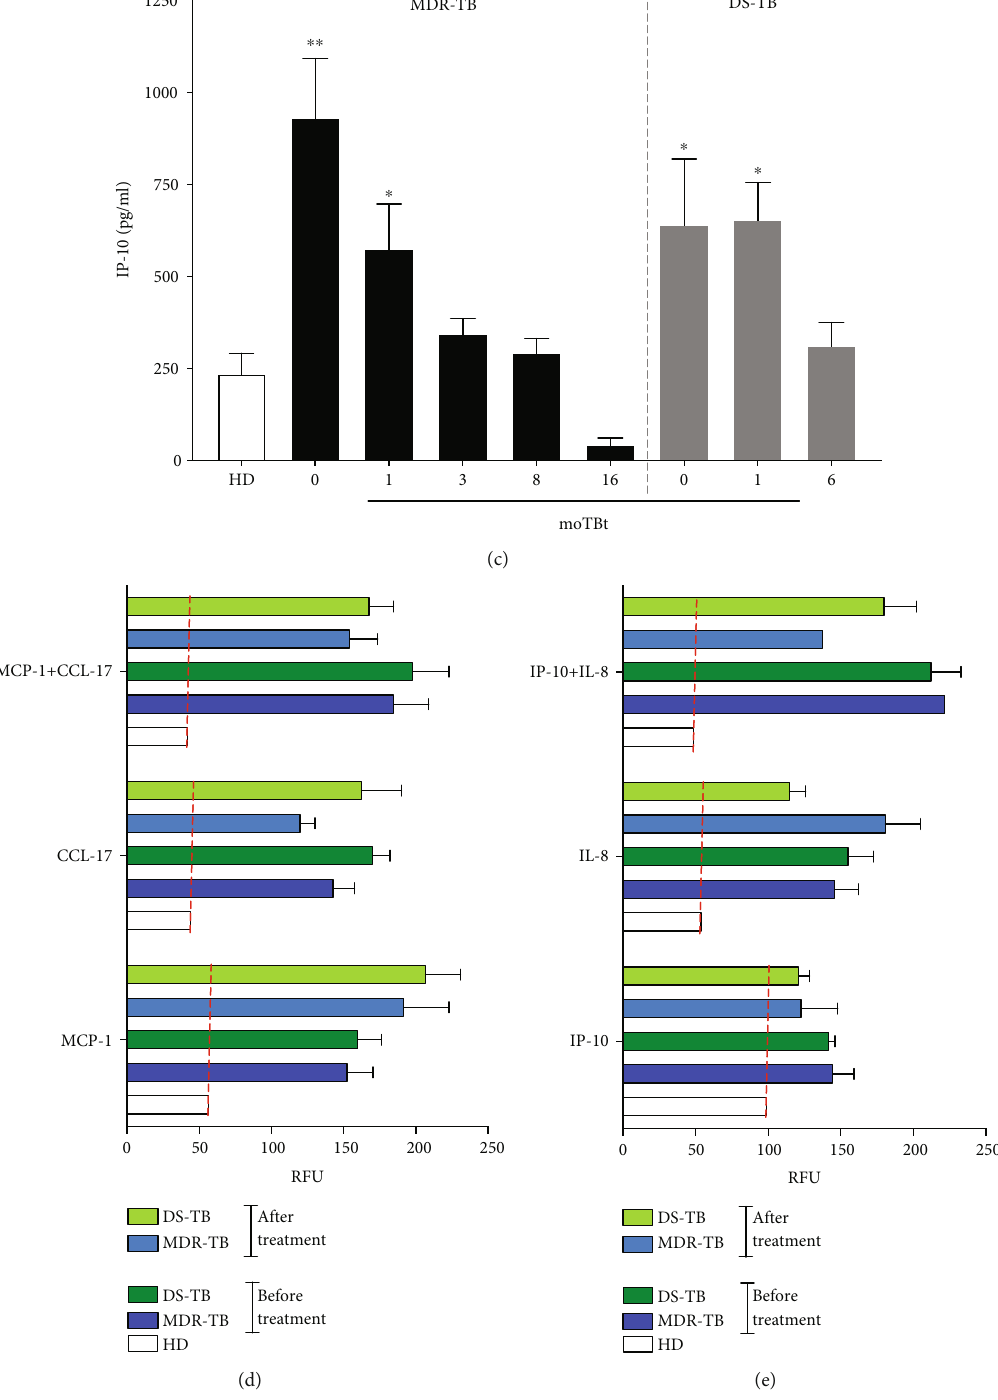
Figure 8: Plasma chemokine levels and migration capacity of leukocytes during MDR-TB and DS-TB. Plasma levels of (a) MCP-1, (b) CCL- 17, and (c) IP-10 were determined by ELISA in multidrug-resistant (MDR-TB) and drug-sensitive (DS-TB) patients. (HD: n = 6 , MDR-TB: basal, 1, and 3 moTBt n = 14 , 8 moTBt n = 11 , and 16 moTBt n = 10 . DS-TB: basal and 1 moTBt and 6 moTBt n = 11 ). Peripheral blood mononuclear cells (PBMCs) from DS-TB and MDR-TB patients isolated before and after anti-TB treatment, evaluated for their ability to migrate in response to (d) MCP-1 and CCL17 or (e) IP-10 and IL-8, using a fl uorometric assay (HD: n = 3 , MDR-TB: n = 4 (before treatment) and n = 3 (after treatment), DS-TB: n = 3 ). The relative fl uorescence unit (RFU) is indicative of the magnitude of cellular migration. Bar graphs show means ± standard error of the mean ð SEM Þ . Di ff erences between patient groups and HD at each time point or experimental condition were analyzed using multiple Student ’ s t -test corrected for multiple comparisons using the Sidak – Bonferroni method. ∗ p < 0 : 05 , ∗∗ p < 0 : 01 , ∗∗∗ p < 0 : 001 , and ∗∗∗∗ p < 0 : 0001 . moTBt: months of antituberculosis